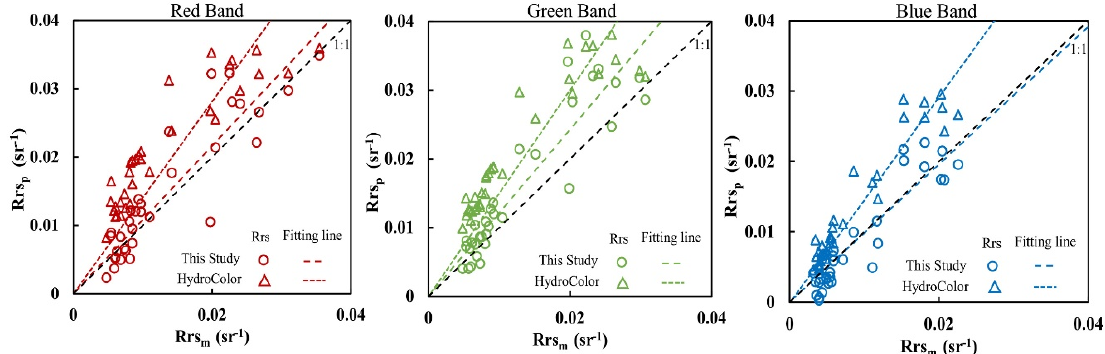
Figure 6. Scatterplots of water leaving reflectance derived from digital images at 31 sampling stations (using the method in this Study vs. the method in HydroColor) and measured by the spectrometer in RGB (red, green, blue) bands. Table 2. Accuracy evaluation of water leaving reflectance derived from digital images acquired at 31 sampling stations using the methods proposed in this study and the HydroColor smartphone application.